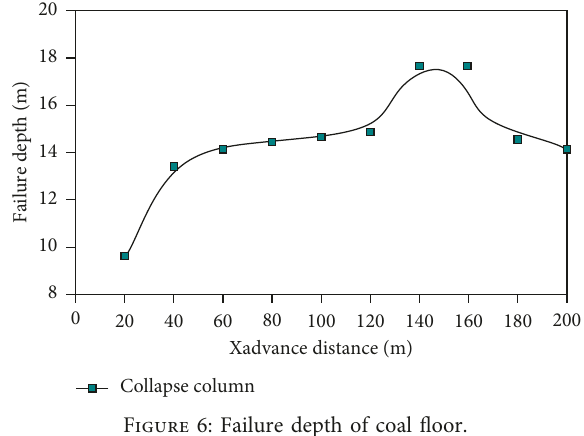
Figure 6: Failure depth of coal